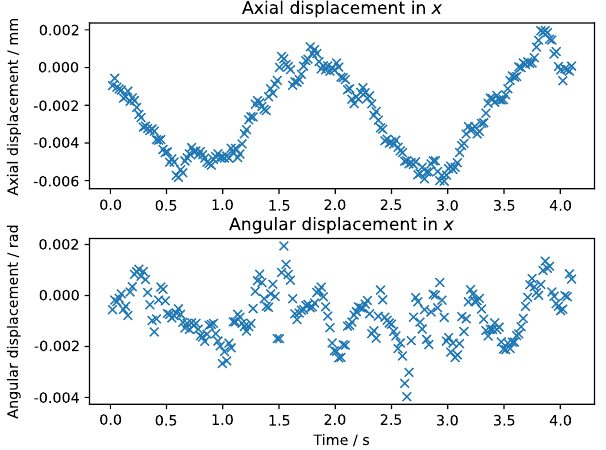
Figure 7. Frequency spectrum of the vibrometer signal. The y axis is scaled to make frequencies different than the excitation frequency visible. The amplitude of f ex = 106 . 25Hz is 189.3ms − 2 .